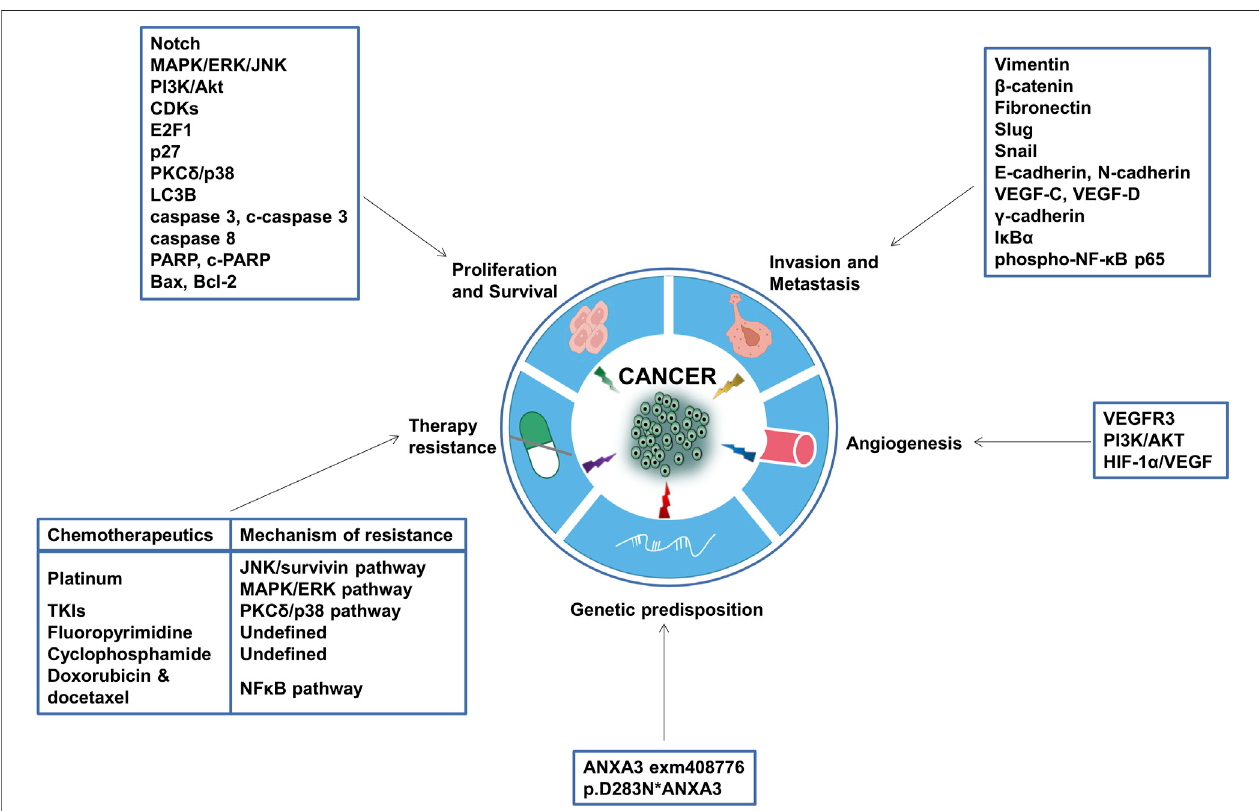
FIGURE 4 | Tumorigenic functions of ANXA3. Aberrant expression of ANXA3 can exert multifaceted tumorigenic functions, such as promoting tumor cell proliferation, invasion, metastasis and angiogenesis, enhancing the propensity to form certain inherited tumors, and inducing resistance to chemotherapeutic agents. The putative mechanisms, target genes, effector proteins and pathways through which ANXA3 modulates these processes are annotated in the square text boxes. CDKs,Cyclin-dependentkinases;p27,Cyclin-dependentkinaseinhibitor1B;p38,p38mitogen-activatedproteinkinases;LC3B,Microtubule-associatedproteins 1A/1B light chain 3B; PARP, Poly (ADP-ribose) polymerase; bax, Bcl-2-associated X protein; bcl-2, B-cell lymphoma 2; VEGF, Vascular endothelial growth factor; I κ B α , nuclear factor of kappa light polypeptide gene enhancer in B-cells inhibitor, alpha; NF- κ B, nuclear factor kappa-light-chain-enhancer of activated B cells; VEGFR, Vascular endothelial growth factor receptor; HIF-1 α , Hypoxia-inducible factor 1-alpha.